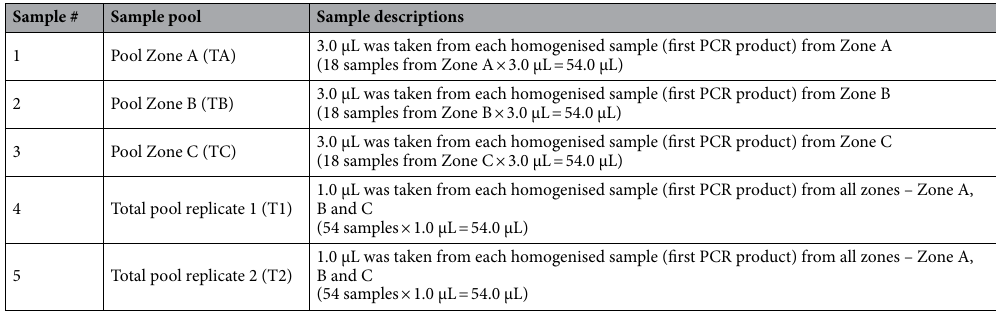
Table 3. Descriptions of pooling mechanism for each sample pool before the second index